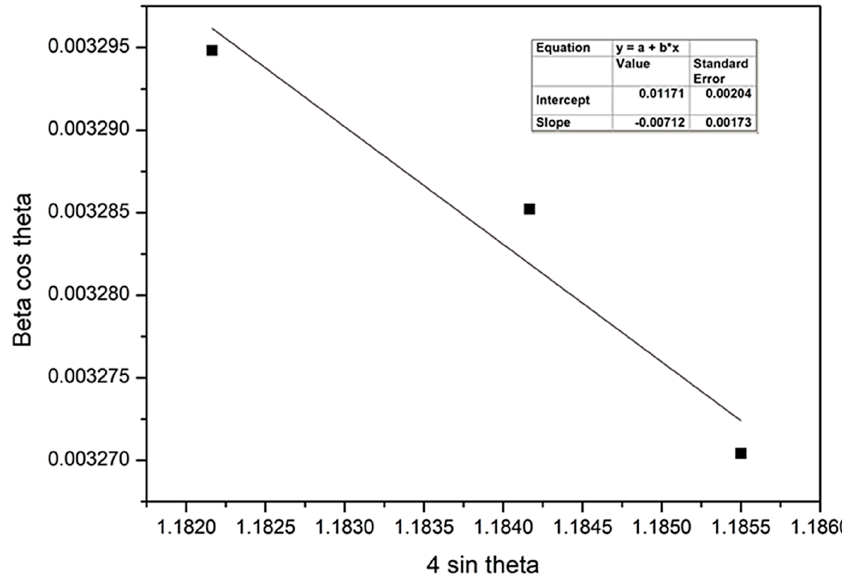
Figure 5. Williamson–Hall plot of as-deposited WS 2 film at 7 sccm of Ar flow rate.